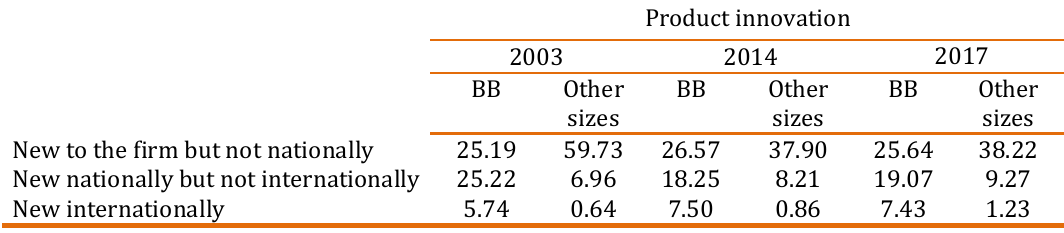
Product innovation 2003 2014 2017 BB Other BB Other BB Other sizes sizes sizes